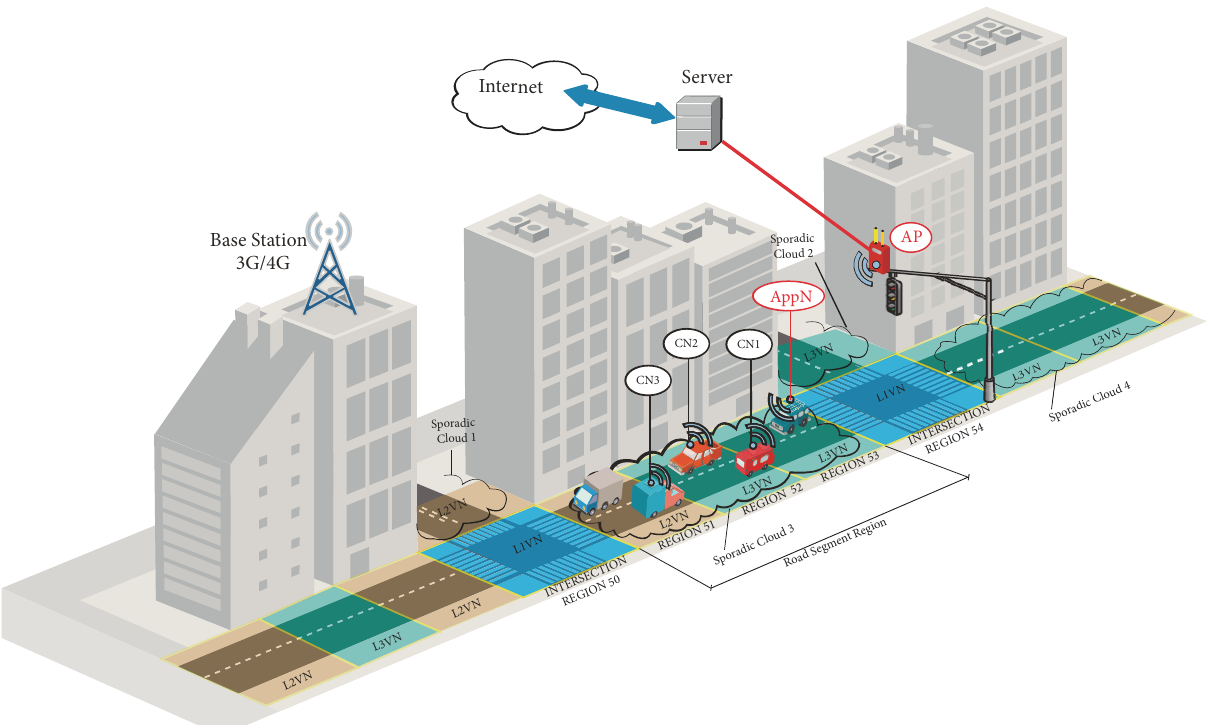
Figure 2: Distribution of static virtual nodes and definition of L1VN, L2VN, and L3VN in our